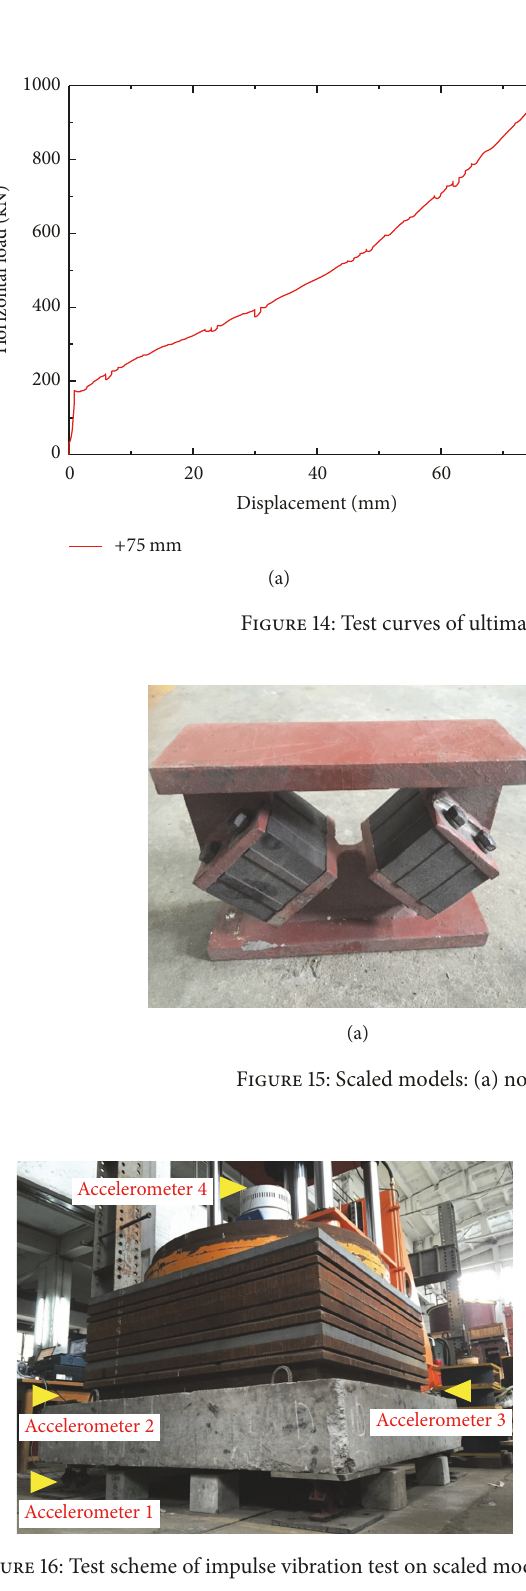
of upper and lower plates are 0.073 m/s 2 and 0.0021 m/s 2 , with main frequency components around 20–30 Hz or 65–75